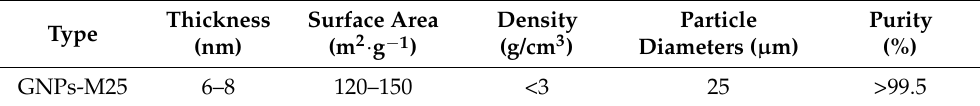
Table 1. Characteristics of